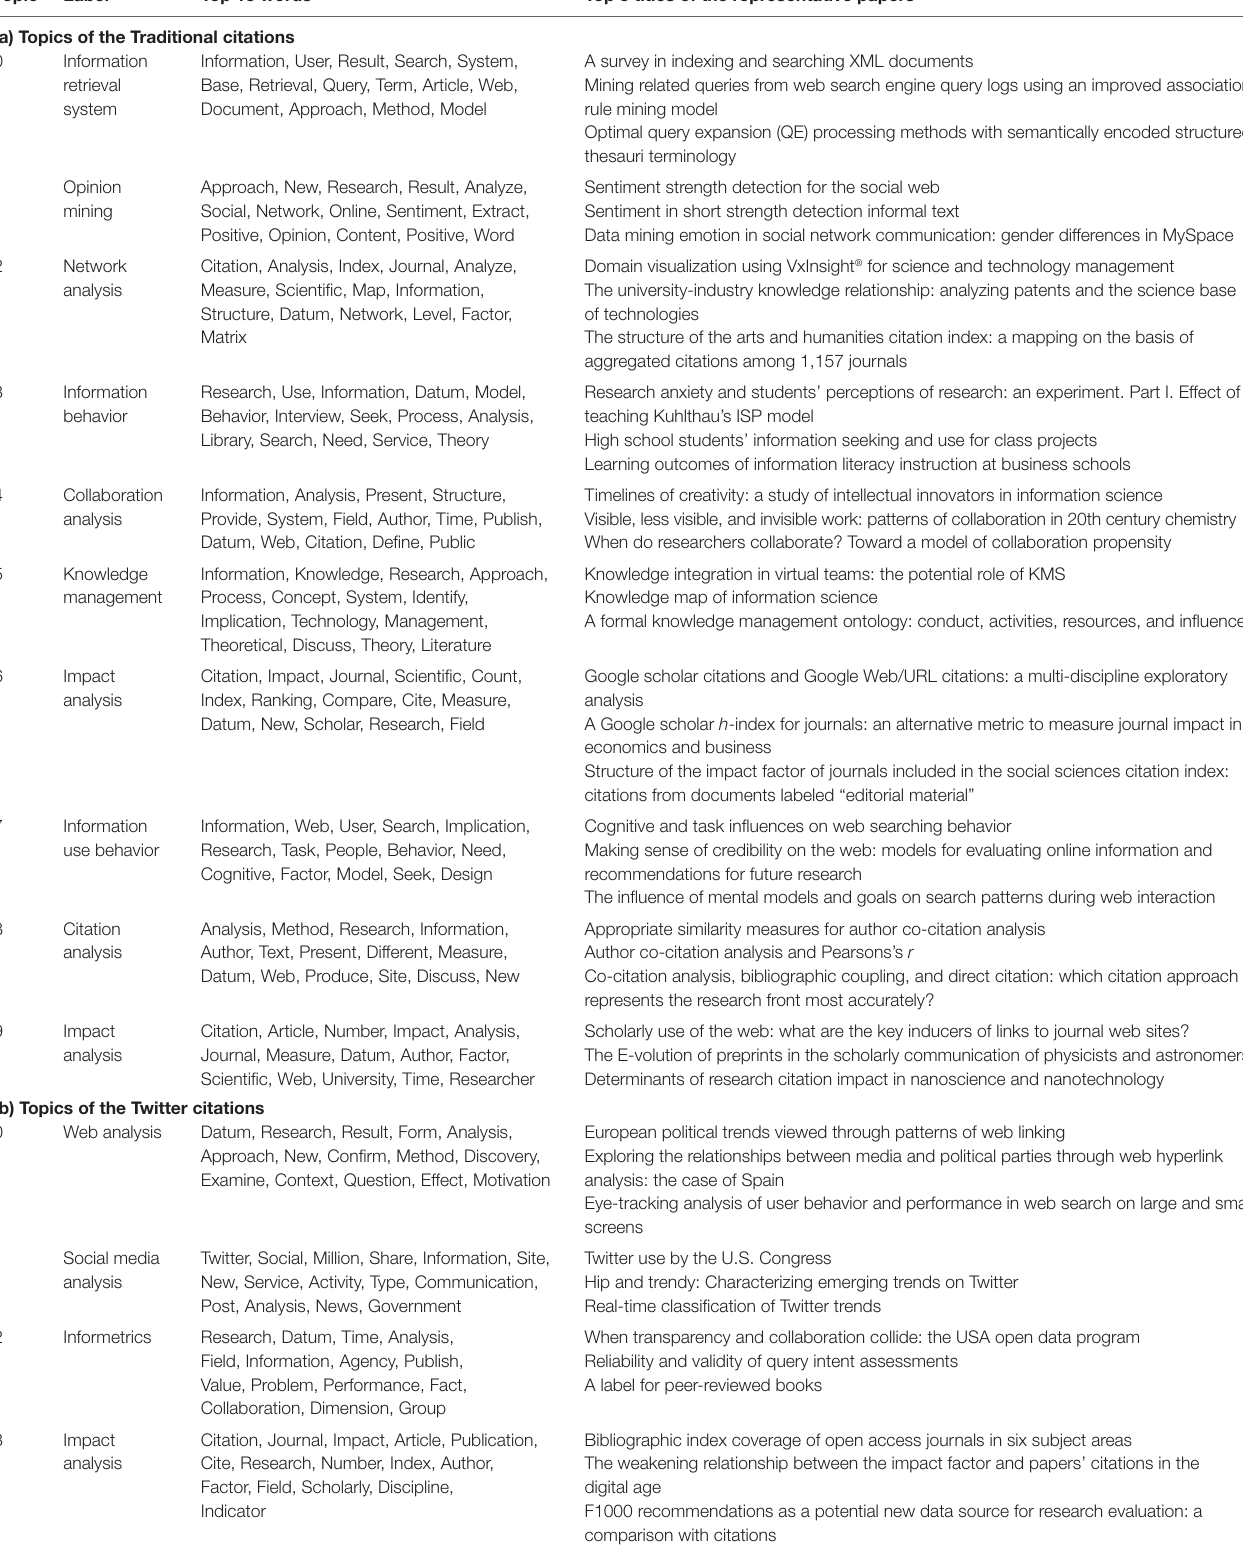
TaBle 3 | Descriptions of the topics of (a) traditional and (b) Twitter citations from a DMr topic model. Topic Top 15 words Top 3 titles of the representative